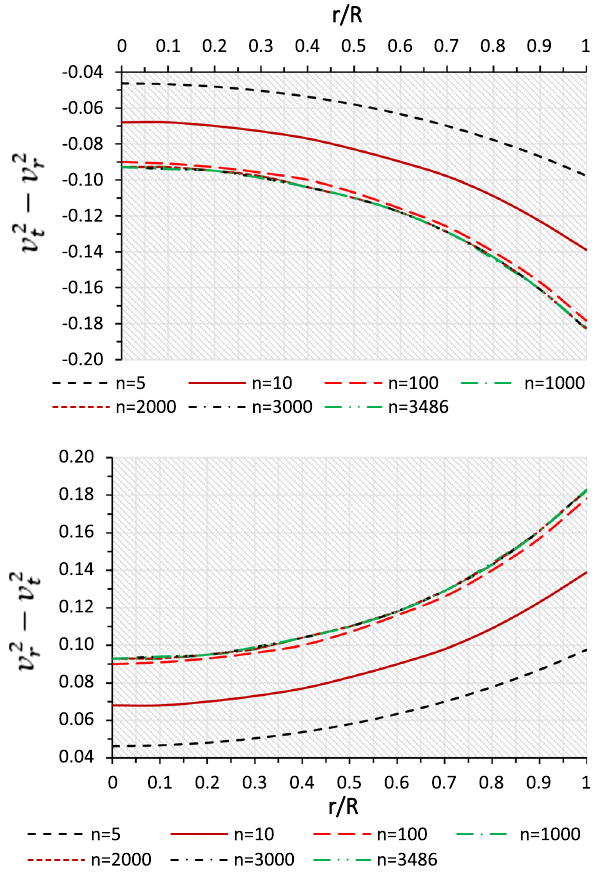
Fig. 10 Variation of velocity difference (v 2 t − v 2 r ) and ( v 2 r − v 2 t ) vs. radial coordinate r / R with different values of n for LMC X − 4